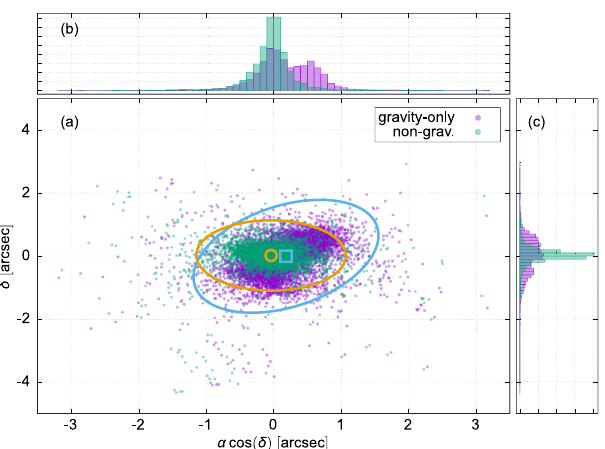
Fig. 1 Optical astrometry observed-minus-computed residuals. a The horizontal axis corresponds to right-ascension residuals and the vertical to declination residuals. Purple circles correspond to the residuals obtained from the gravity-only solution ( A 2 = 0), and the average residual is illustrated as a blue square. Green circles correspond to the non-gravitational solution residuals; their average is marked with an orange circle. The ellipses centered at each average residual value represent the 3- σ level con fi dence. b Frequency histogram of right-ascension residuals. c Frequency histogram of declination residuals. Notice that the purple histograms display bimodal (two mode)